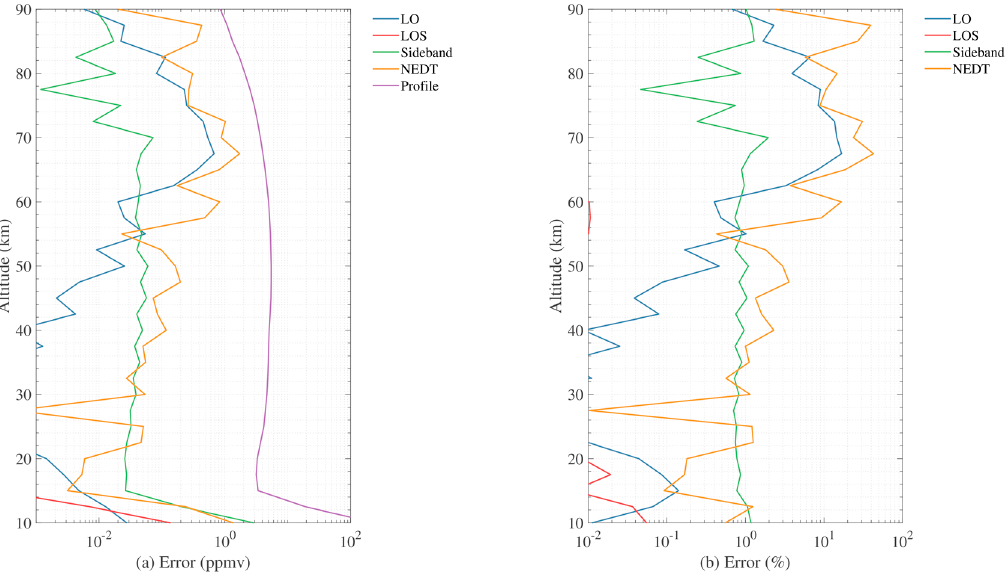
Figure 9. The H 2 O retrieval errors induced by different instrument uncertainty sources: ( a ) absolute and ( b ) relative retrieval errors. The uncertainties assumed are summarized in Table 3.